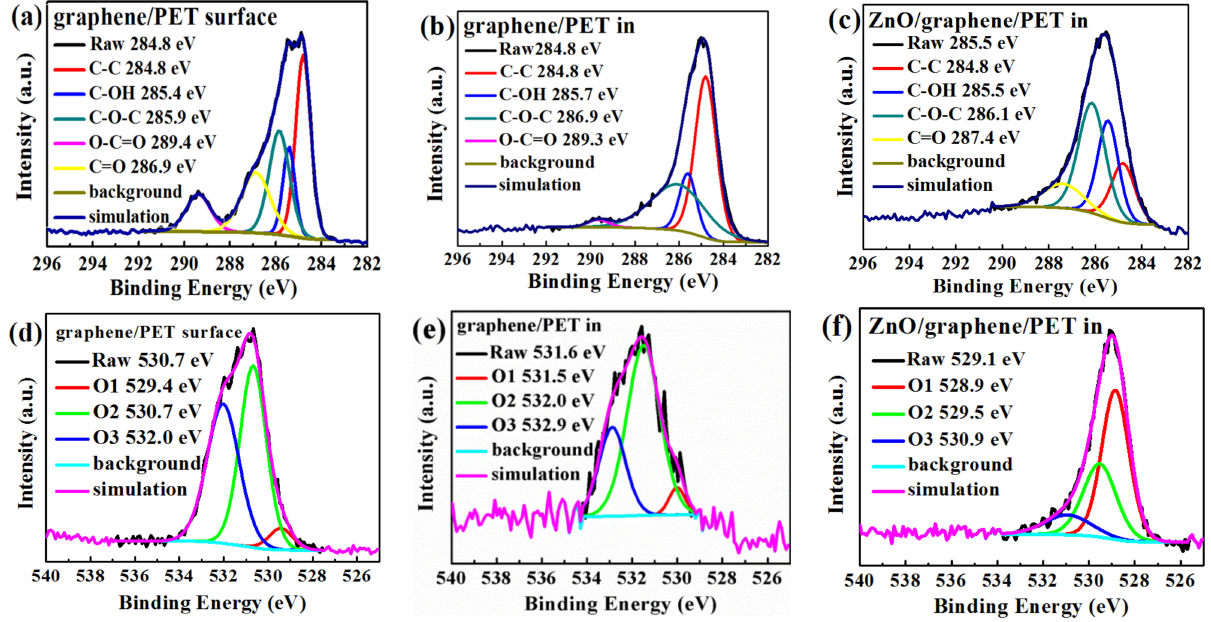
Figure 7. The C1s XPS spectra of the ( a ) graphene surface, ( b ) graphene/PET interface, and ( c ) ZnO/graphene interface; the O1s XPS spectra of the ( d ) graphene surface, ( e ) graphene/PET interface, and ( f ) ZnO/graphene